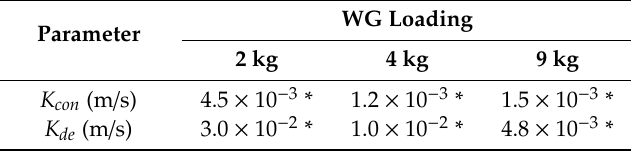
Table 2. Parameter listed as di ff erent WG loading operated; other parameters referred